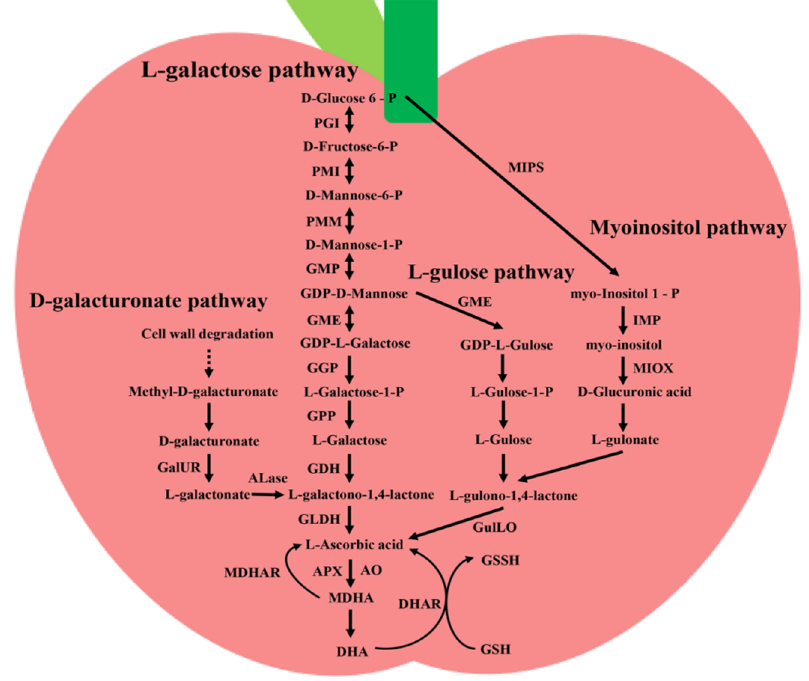
Figure 1. The AsA metabolic pathway in plants. The main pathways for ascorbic acid synthesis in plants are L-galactose pathway, Myoinositol pathway, L-gulose pathway, and D-galacturonate pathway. Alase, aldono-lactonase; AO, ascorbate oxidas; APX, ascorbate peroxidase; DHA, dehydroascorbic acid; DHAR, dehydroascorbate reductase; GalUR, D-galacturonate reductase; GDH, L-galactose dehydrogenase; GGP, GDP-L-galactose-phosphorylase; GLDH, L-galactono-1,4-lactone dehydrogenase; GME, GDP-D-mannose3 (cid:48) , 5 (cid:48) -epimerase; GMP, GDP-mannose pyrophosphorylase; GPP, L-galactose-1-phosphate phosphatase; GSH, glutathione; GSSH, oxidized glutathione; GulLO, L-gulono-1,4-lactone oxidase; IMP, myoinositol monophosphatase; MDHA, monodehydroascorbic acid; MDHAR, monodehydroascorbate reductase; MIOX, myoinositol oxygenase; MIPS, myoinositol phosphate synthase; PGI, phosphoglucose isomerase; PMI, phosphomannose isomerase; PMM, phosphomannomutase.